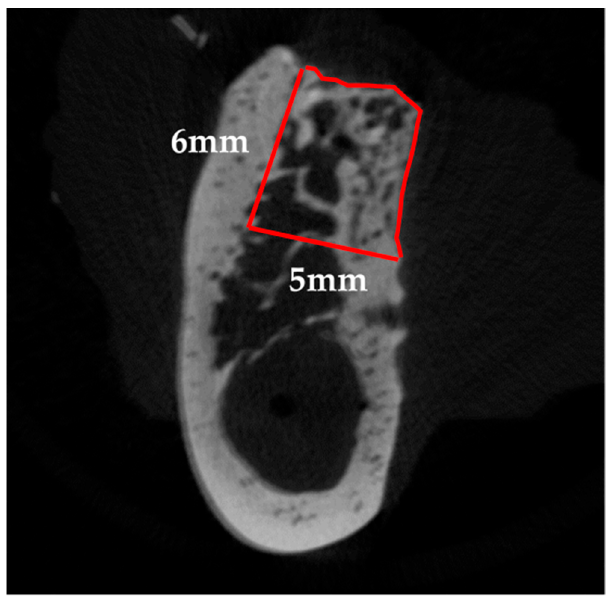
Figure 4. Radiographic analysis. The red line represents the region of interest (ROI). On the sections, 12 mm away from the mid-section, both mesially and distally, the range surrounded by the linear margin of the bone defect (6-mm height, 5-mm base) and the perimeter of the newly formed bone was manually outlined after identifying the border between the bone defect and the host bone.